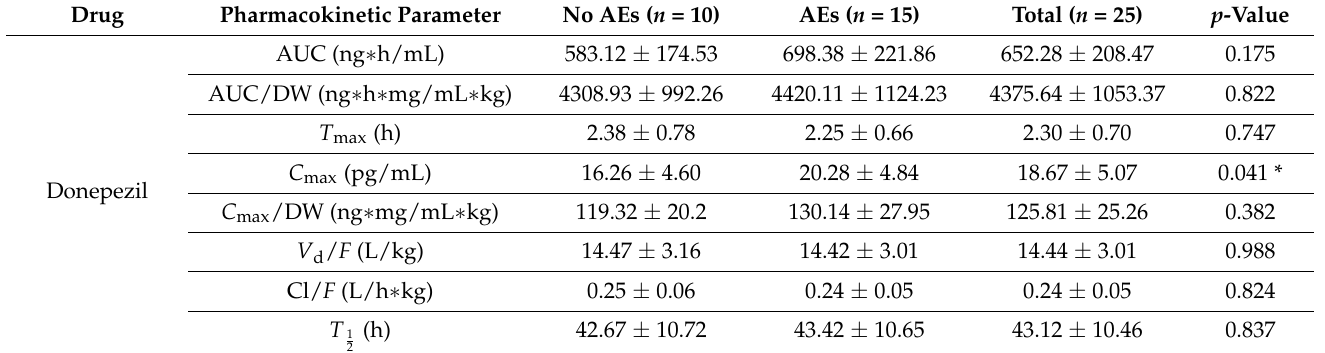
Table 5. Global analysis of adverse effects associated with pharmacokinetic parameters. Drug Pharmacokinetic